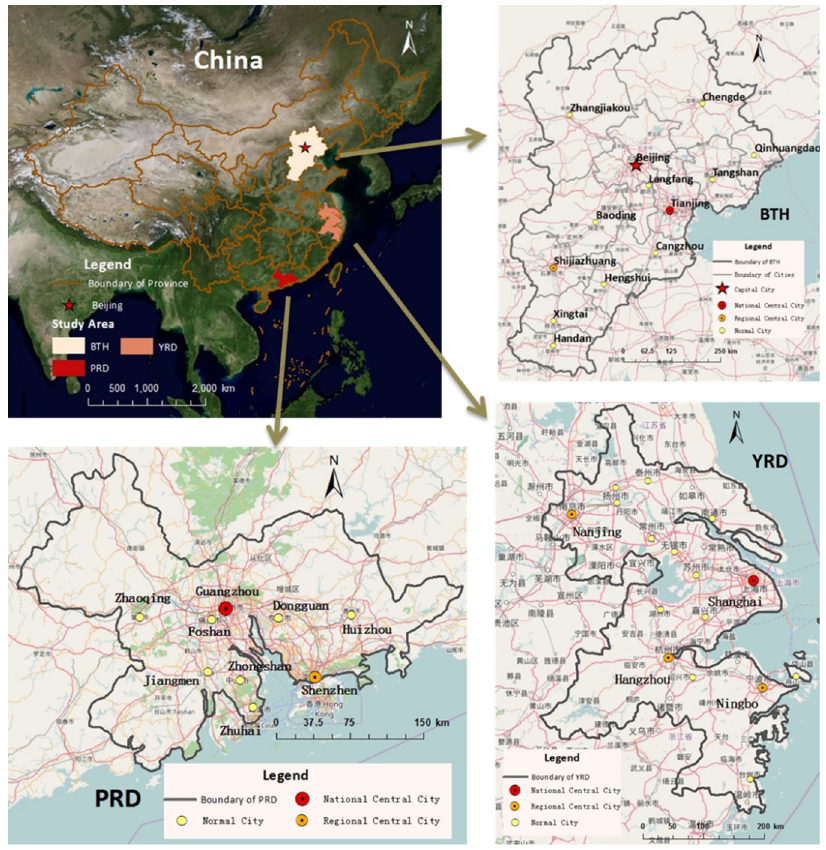
Figure 1. Location of the study area.